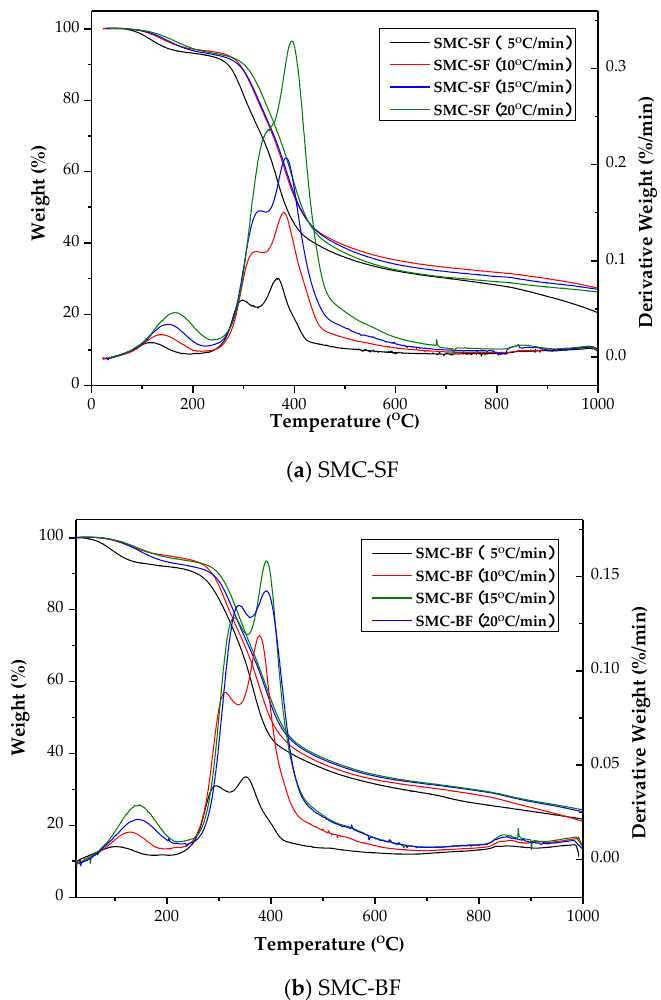
Figure 2. TGA/ DTG curves of ( a ) SMC- shiitake fungus (SMC-SF) and ( b ) SMC-black fungus (SMC-BF) at various heating rates (5, 10, 15 and 20 ◦